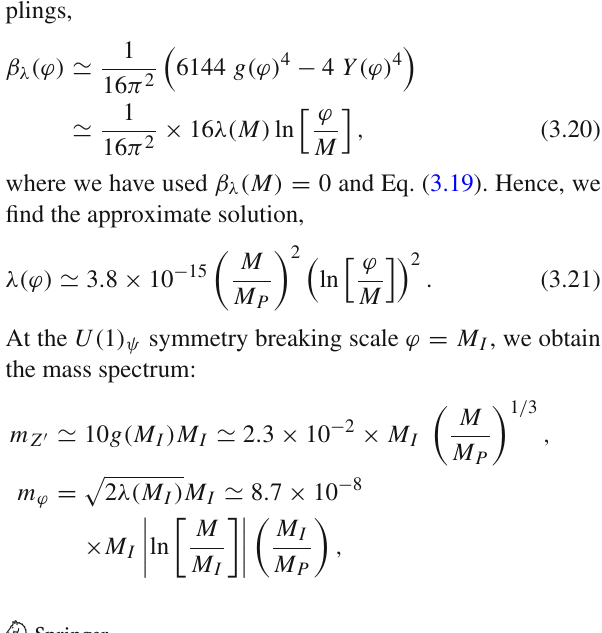
horizontal line corresponds to λ = 0. The right panel shows the RG improved effective inflaton potential with an (approximate) inflection- point at ϕ (cid:2)